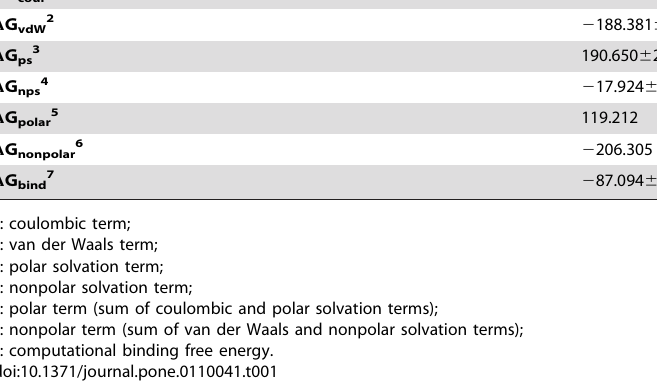
Binding free energies (kJ/mol)